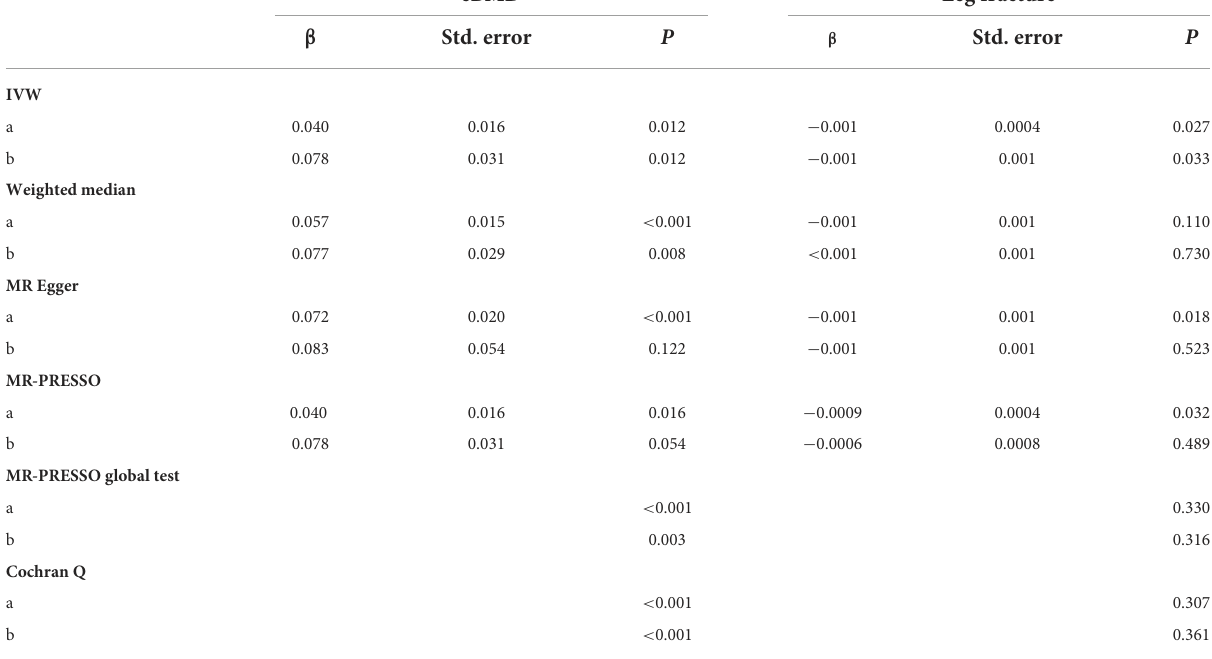
TABLE 2 Multivariable MR results for childhood obesity on eBMD and leg fracture